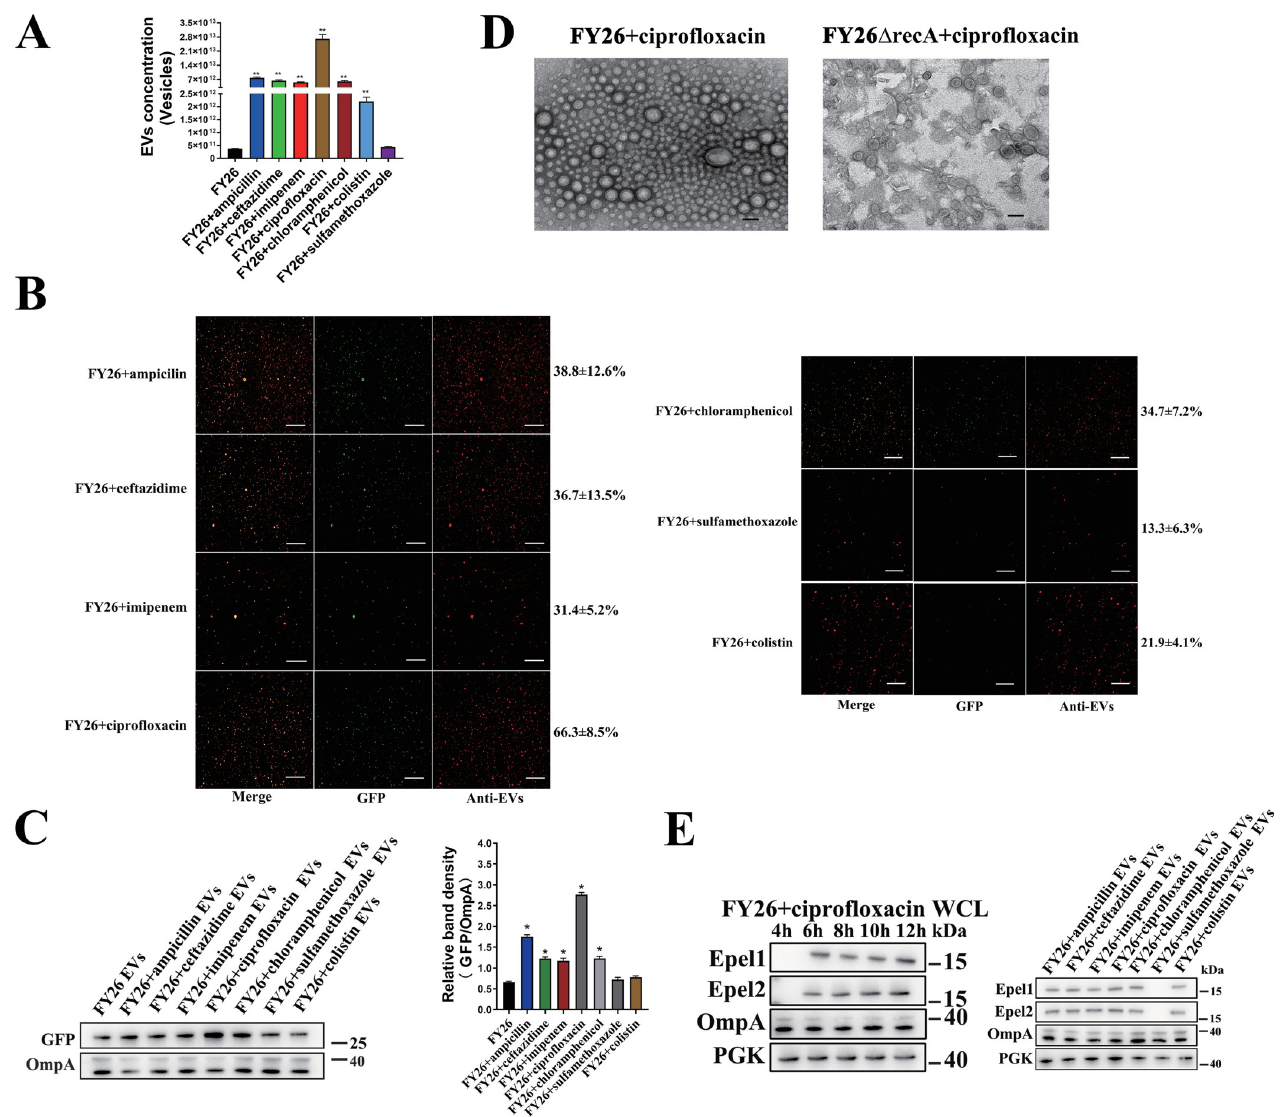
Fig 12. Antibiotics enhance the production of ExPEC EVs. (A) The concentrations of purified EVs in FY26 cultured with sublethal concentrations of antibiotics were determined with a nanoparticle tracking analysis (NTA). FY26 strain was treated with sublethal doses of seven antibiotics (ampicillin, 2 μ g/mL; ceftazidime, 0.3 μ g/mL; imipenem, 2.5 μ g/mL; ciprofloxacin, 0.3 μ g/mL; chloramphenicol, 2 μ g/mL; colistin, 0.3 μ g/mL, sulfamethoxazole, 2 μ g/mL). (B) Immunofluorescent staining of EVs produced by FY26 strains treated with sublethal concentrations of antibiotics. Proportion of cytoplasm-carrying vesicles is indicated on the right. (C) GFP and OmpA proteins in EVs were determined with western blotting. (D) The purified EVs in FY26 cultured with sublethal concentrations of antibiotics were observed with transmission electron microscopy (TEM). Scale bars: 200 nm. (E) Protein levels of endolysins Epel1 and the Epel2 variants in whole-cell lysates (WCLs) and EVs of FY26 strain cultured with sublethal concentrations of antibiotics were determined with western blotting. determined with western blot. The result indicated that the proportion of cytoplasm-carrying EVs produced by FY26 Δ recA incubated with antibiotics was consistent with the expression level of GFP protein (S13F Fig). TEM images showed that the vesicles were predominantly sin- gle-layered vesicles (EOMVs) with a few double-bilayer vesicles (OIMVs) when FY26 Δ recA was exposed to sublethal level of ciprofloxacin (Fig 12D). qRT-PCR showed that the transcrip- tion levels of epel1 , epel2 . 1 , and epel2 . 2 were clearly lower in FY26 Δ recA cultured with